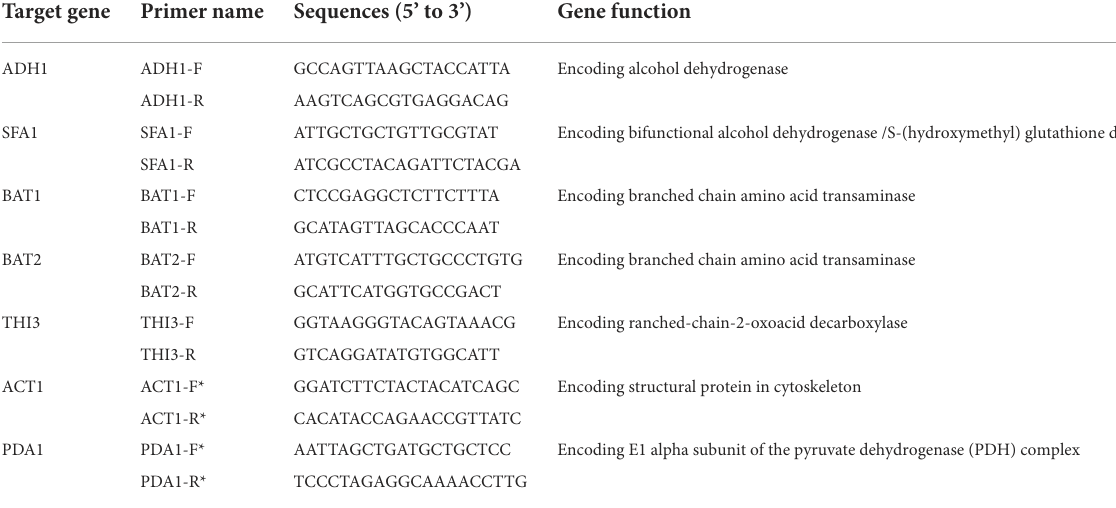
TABLE 2 The details of primers used for RT-qPCR